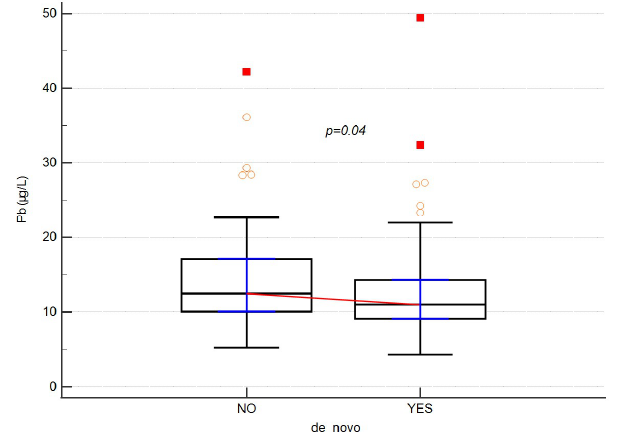
Figure 4. Levels of lead with regard to disease onset. Empty dots represent individual data. Red squares are outliers.